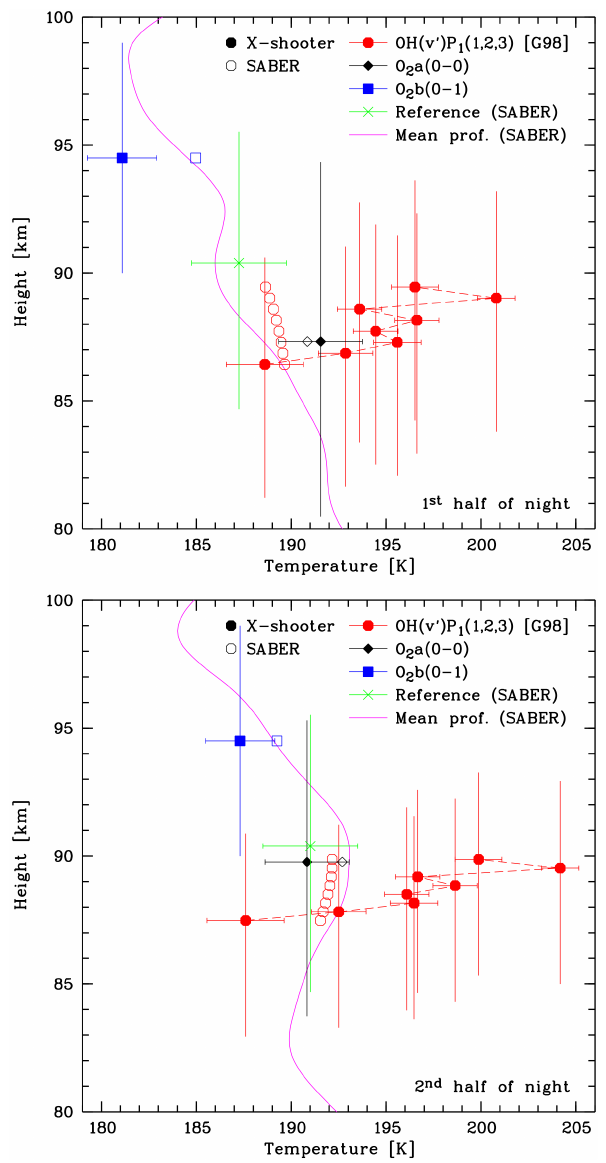
Figure 17. Same plot as Fig. 12 except for showing results for the first (upper panel) and the second half of the night (lower panel)